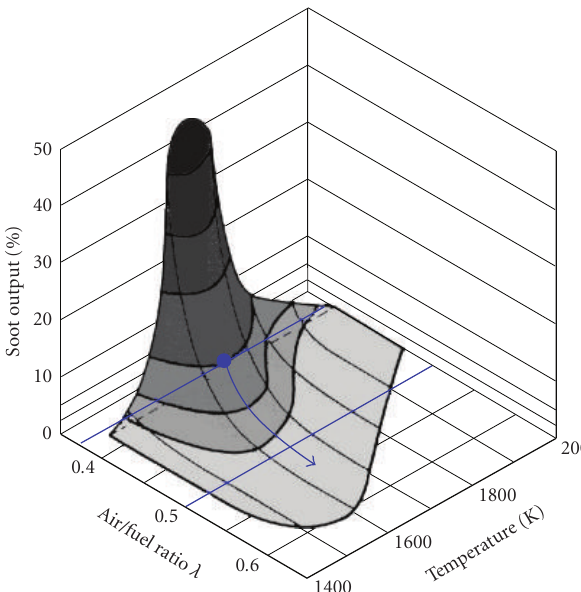
Figure 3: Temperature and λ conditions for soot formation [10, 11].